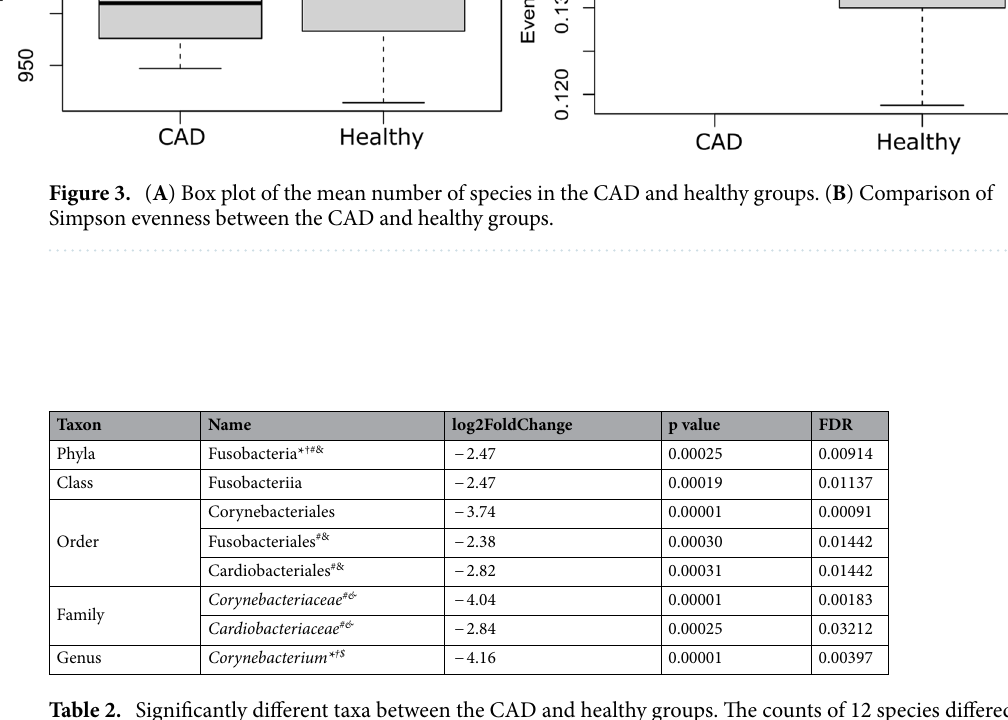
Table 2. Significantly different taxa between the CAD and healthy groups. The counts of 12 species differed significantly between the CAD and healthy groups, and all these species had fewer counts in the CAD group than in the healthy group (Table 3; Fig. 4). One of the significant species was F. nucleatum (Log2 Fold change = − 2.63, FDR = 4.8%), a bacterium belonging to the orange subgingival plaque complex. *Contaminant; # Hard palate; & Soft palate; % Tonsils; $ Tooth surfaces; † Subgingival and supragingival plaques; §